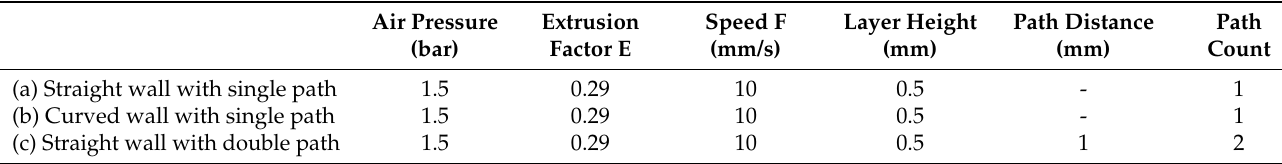
Table 3. Print parameters of the tested digital models in Figure 2.